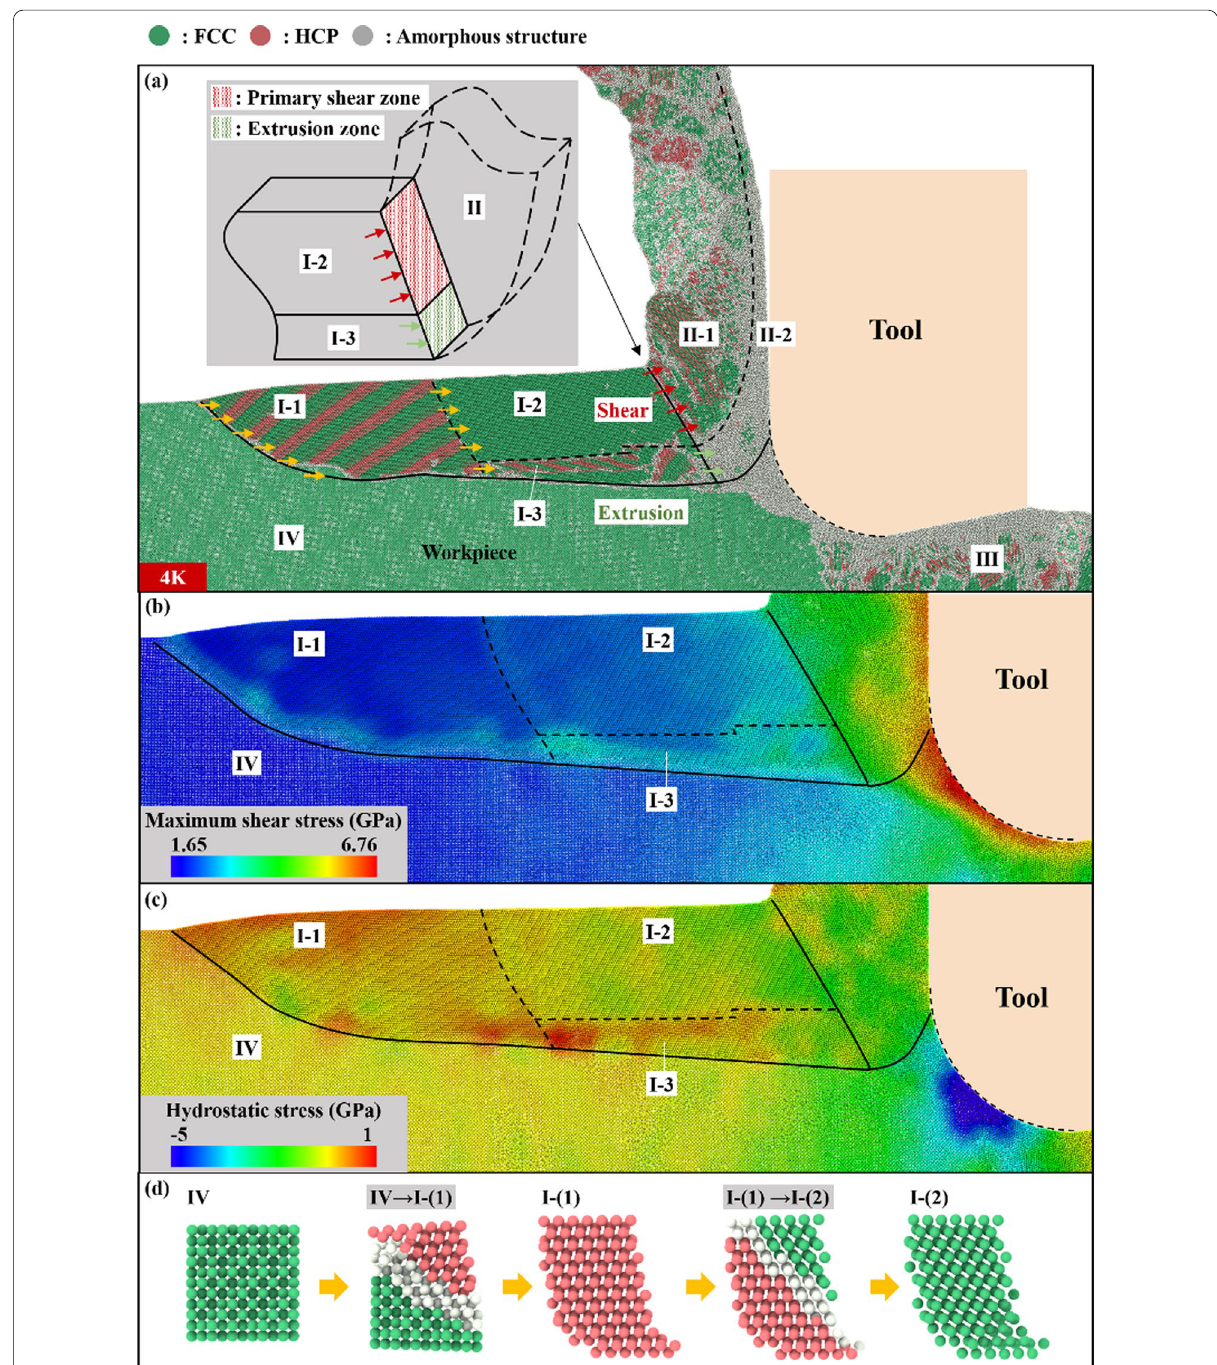
Fig. 6 Morphology of chip root at 4 K, a crystal structure distribution, b crystal structure change process, c maximum shear stress distribution, d hydrostatic pressure